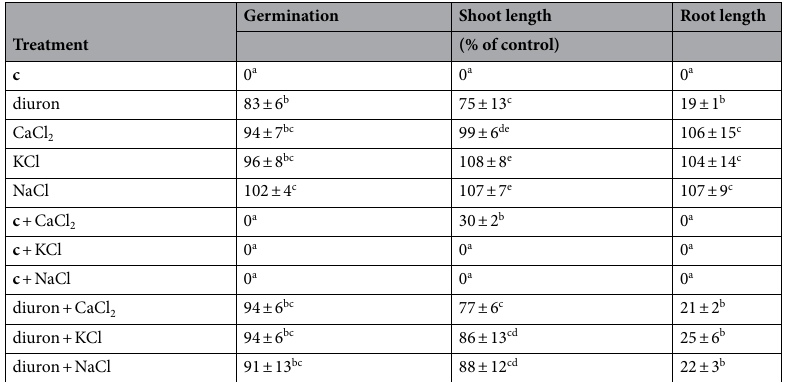
Table 5. Inhibitory effect of c (125 mg/L) and diuron (125 mg/L) added with or without metal chlorides (50 mg/L) on germination, shoot growth and root growth of Eleusine indica after 7 days of treatment. Data indicate the mean ± standard deviation of five replicates. *Means followed by similar small letters within the same column have no significant differences ( p > 0.05) among